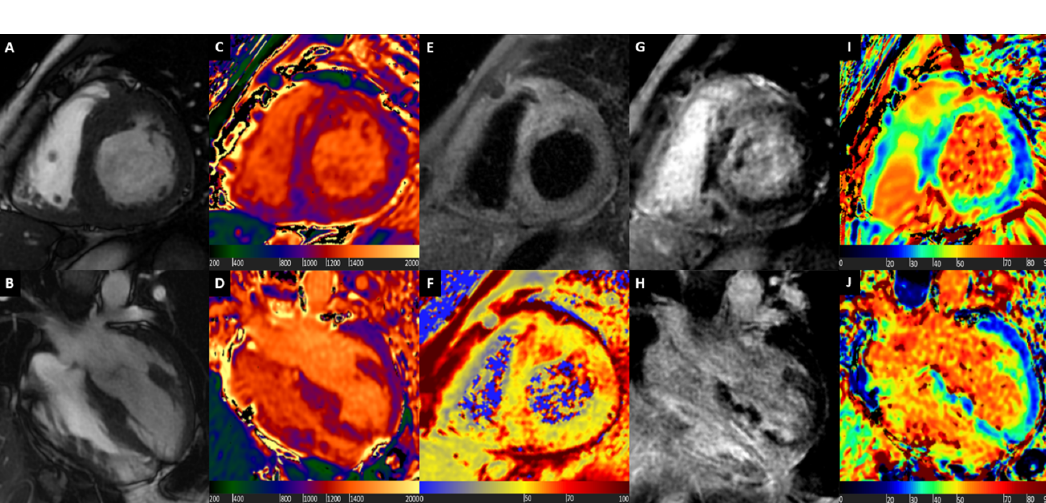
Figure 5. Cardiac Sarcoidosis. Basal short axis view (Box A ) and 4-chamber long axis view (Box B ) balanced steady state free precession images showing asymmetric myocardial hypertrophy at septum. Focal increase of T1 values at native T1 mapping images at septum and inferior wall (Boxes C and D ). Myocardial oedema detected by T2-wieghted images (Box E ) and T2 mapping (Box F ), mostly at septum and inferior wall. LGE images show transmural enhancement at septal level, and subepicardial enhancement at inferior wall (Boxes G and H ). Focal increase of ECV, matching native T1 mapping and LGE images abnormalities (Boxes I and J ).